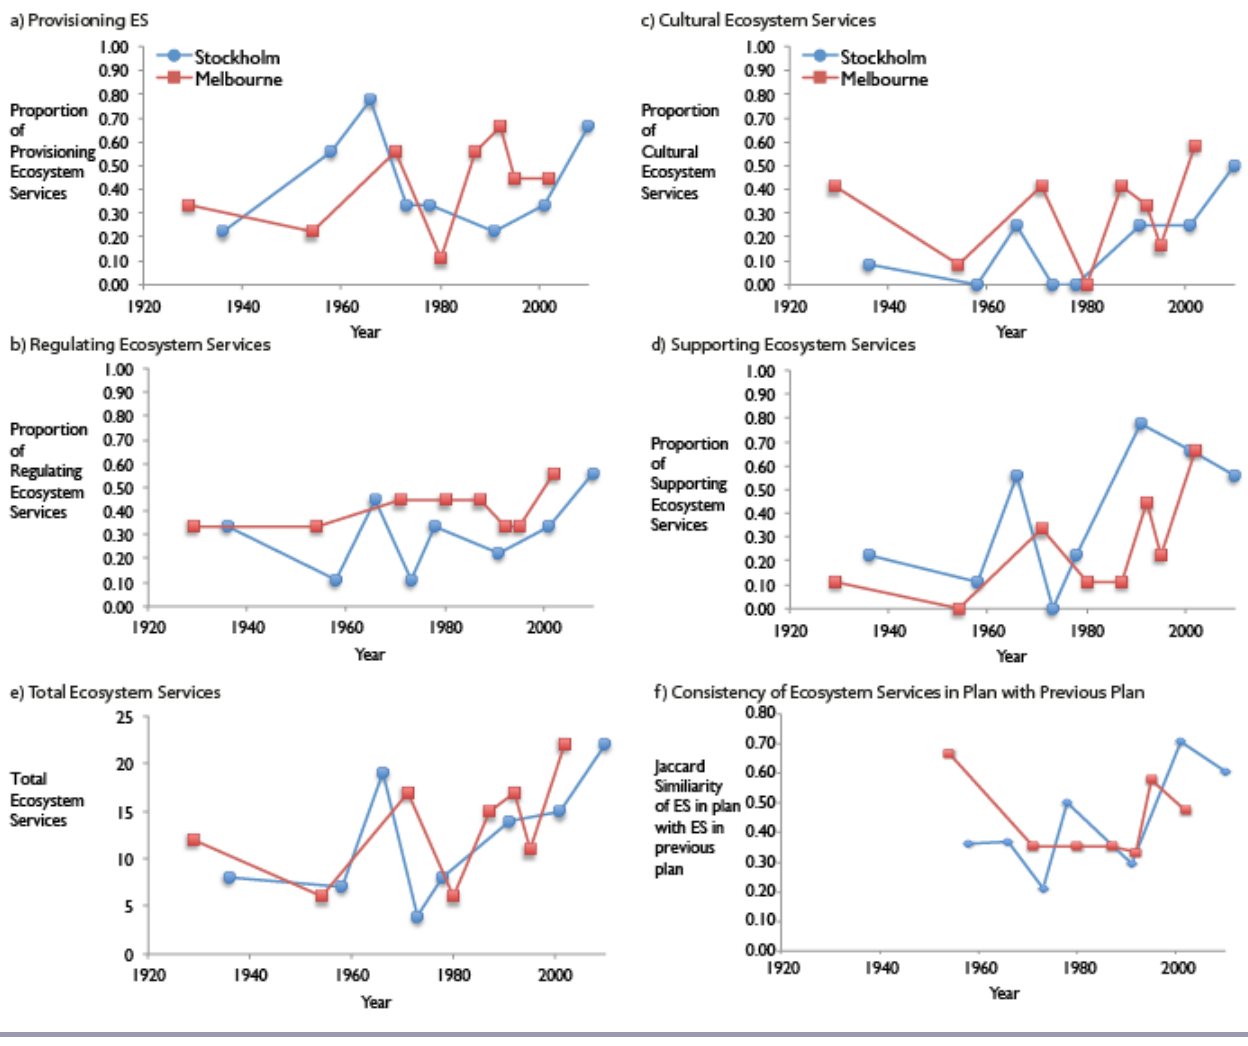
Fig. 2 . Proportion of total ecosystem services addressed for each category, Stockholm and Melbourne compared (a-d); total number of ecosystem services addressed, Stockholm and Melbourne compared (e); consistency of ecosystem services in plan with previous plans